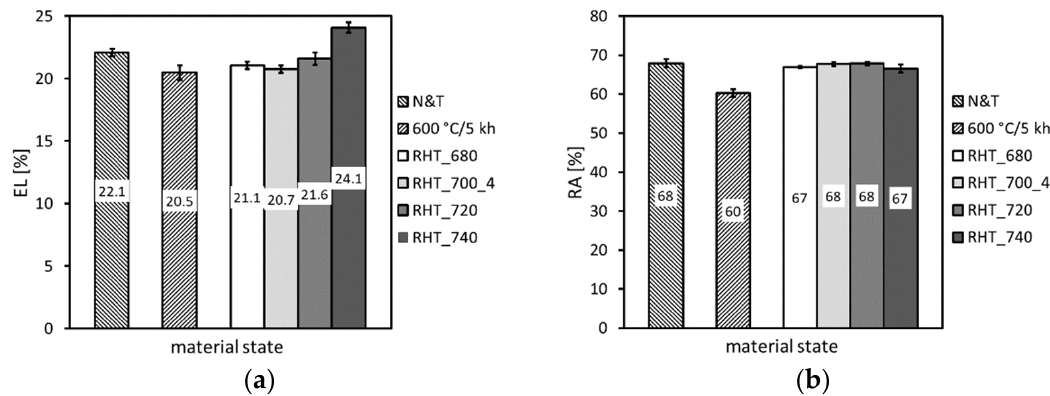
Figure 16. The effect of various annealing temperatures of individual rejuvenation heat treatments with most efficient heating up and cooling down conditions on ( a ) total elongation and ( b ) reduction of area.